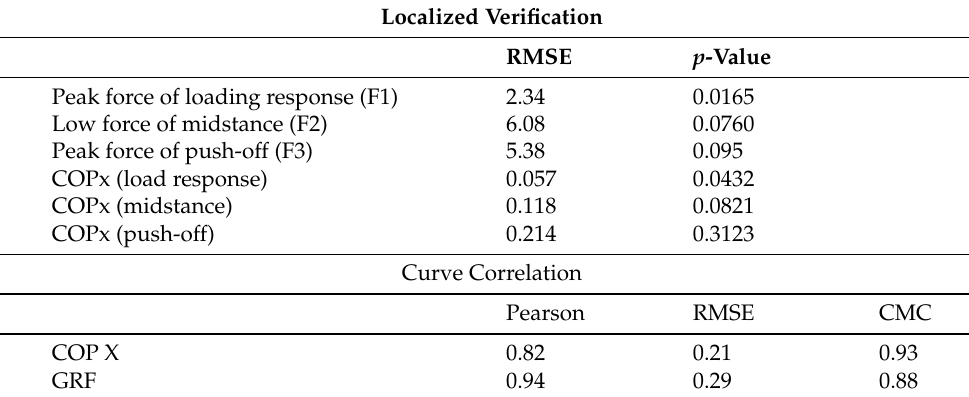
Table A1. Kinetic verification.